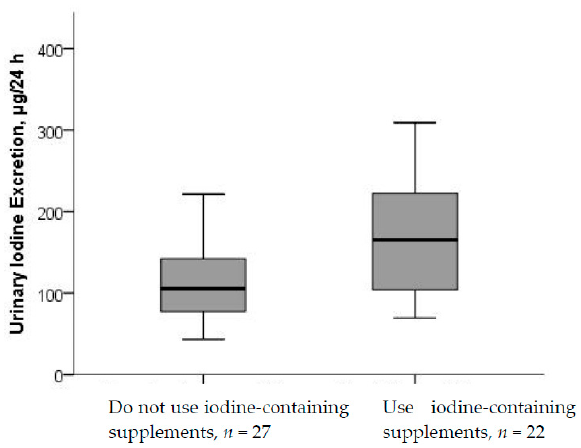
Figure 3. UIE by use of iodine-containing supplements. Differences in UIE between non-supplement and supplement users were significant ( p < 0.021; Mann–Whitney U test).